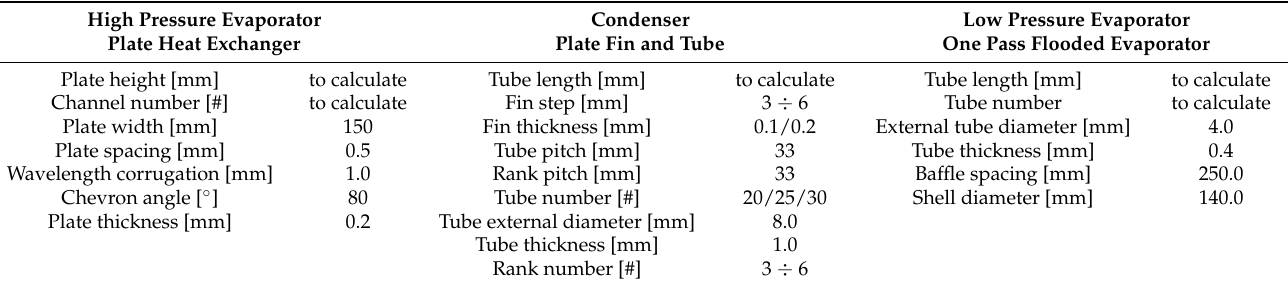
Table A1. Main sizing parameters of the heat